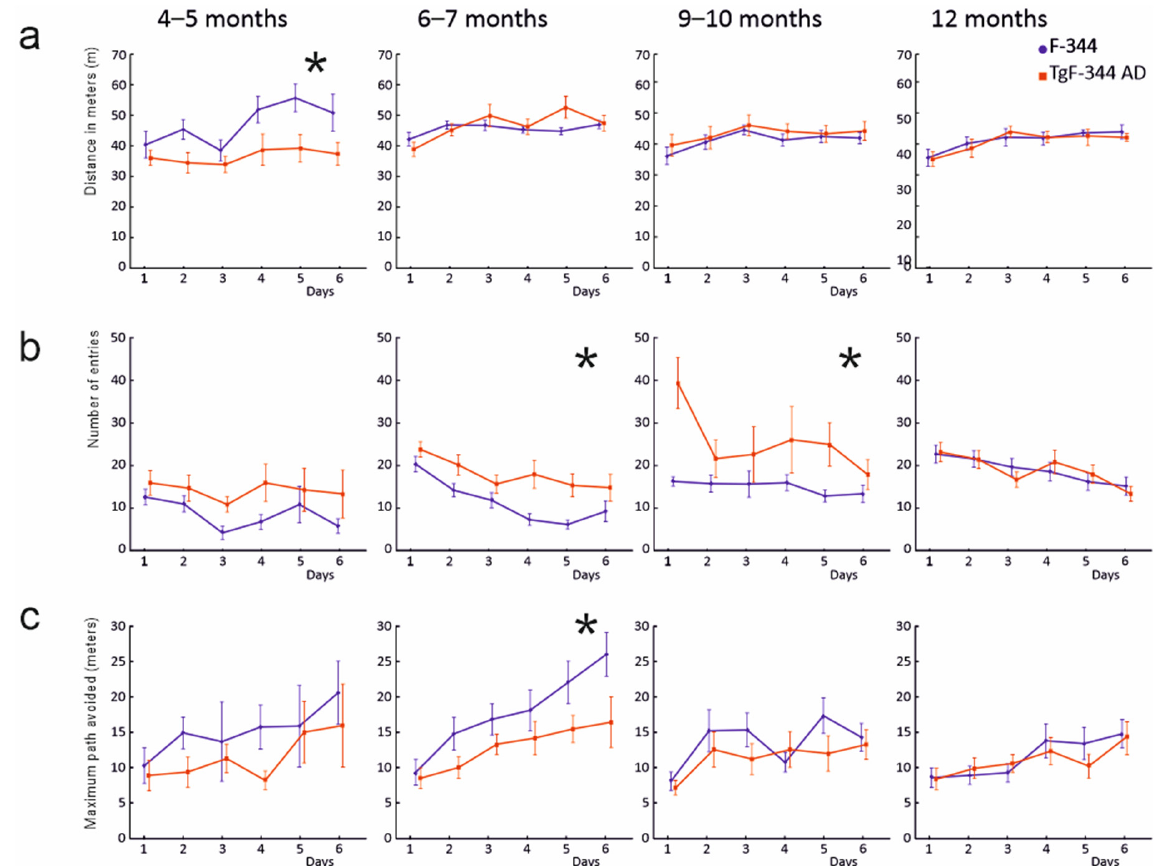
Figure 2. Spatial learning and memory in Active Allothetic Place Avoidance task across all age groups. Transgenic animals are marked in red; wild type animals in blue. Values are depicted as group averages, vertical bars indicate SEM. Statistically significant between-group differences are marked with an asterisk. ( a ) Distance in meters actively travelled in the AAPA arena as a measure of non-cognitive activity in the task. ( b ) Number of errors. Average number of entries into the punished sector of the arena per session. Transgenic rats made significantly higher amount of spatial errors at the age of 6–7 and 9–10 months, compared to the wild controls. ( c ) Maximal path avoidance. Transgenic subjects scored significantly shorter maximal distance avoided than the wild controls at the age of 6–7 months.